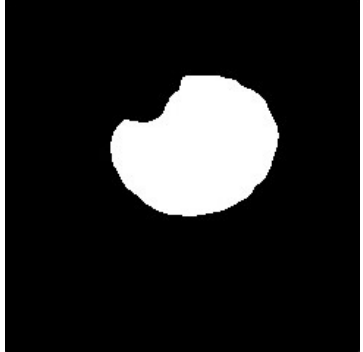
Figure 31. Anti-whited low-threshold image.